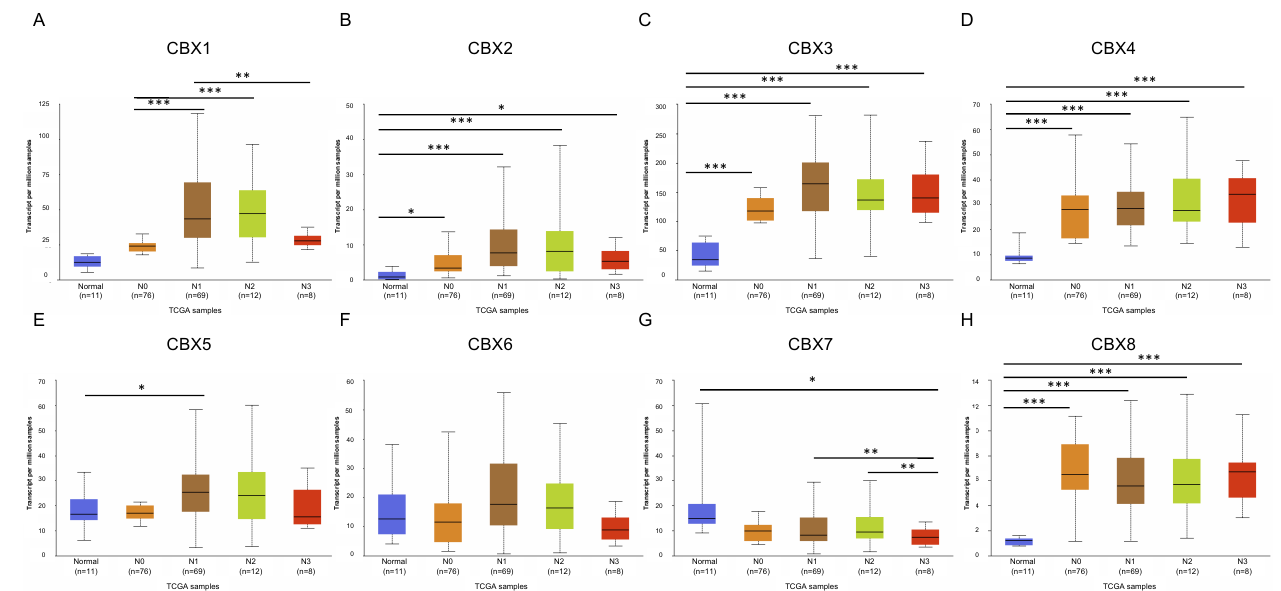
Figure 3. Relationships between the expression of CBX family proteins and nodal metastatic status in EC patients ( A – H ). (UALCAN, * p < 0.05, ** p < 0.01, *** p <